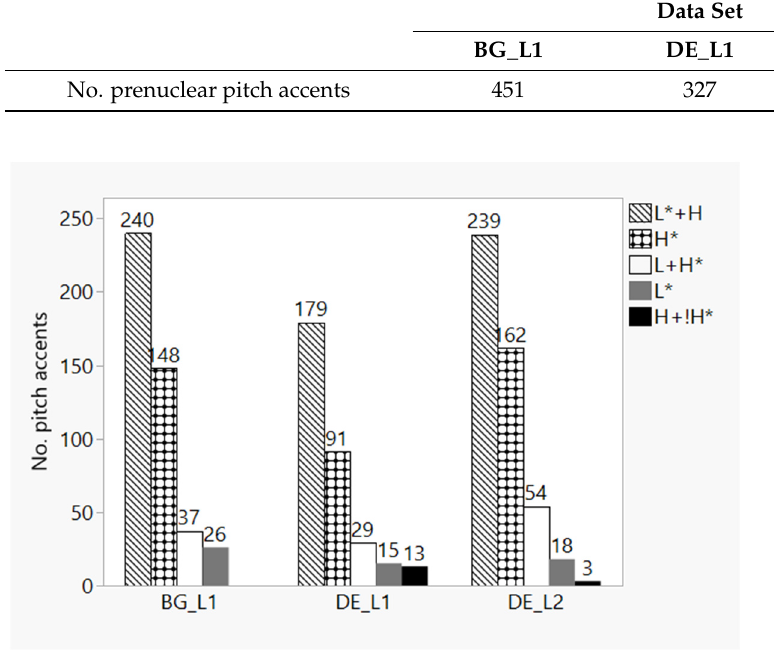
Figure 4. Number of pitch accents in the three data sets. Table 2. Number of prenuclear pitch accents in the three data